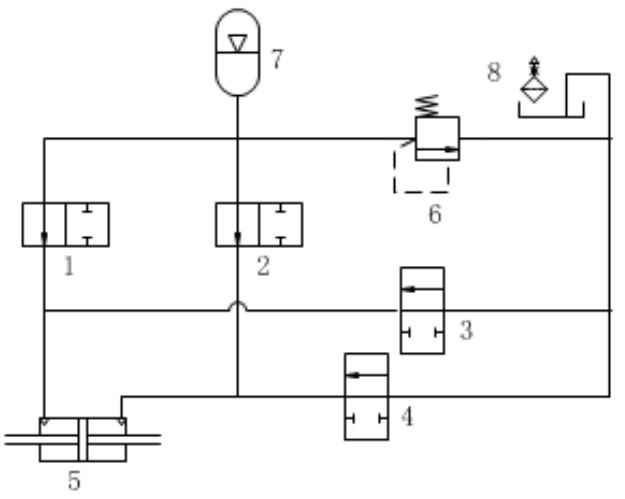
Figure 7. The schematic diagram of the hydraulic loading system.